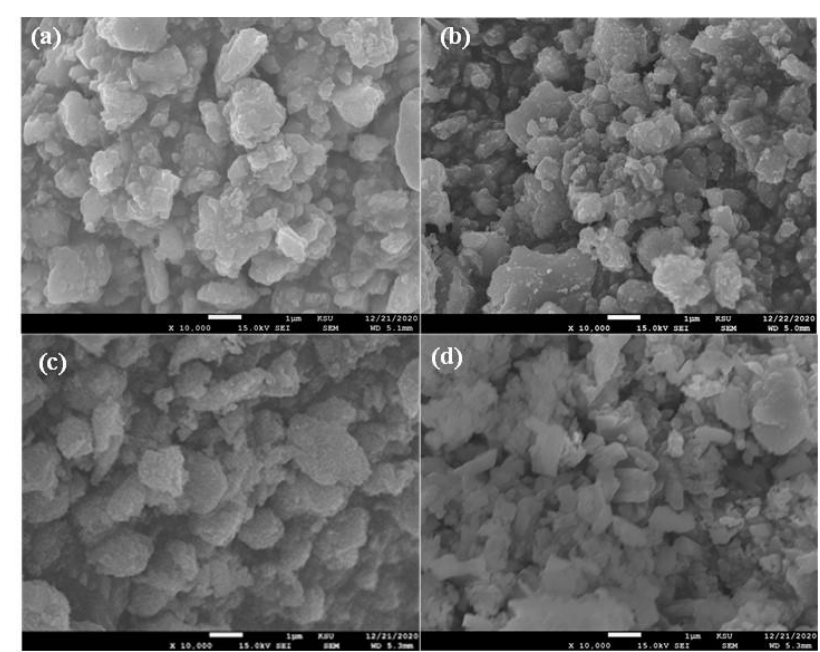
Figure 2. SEM images of ( a ), ( b ) Sr 2 CoO 3 F, ( c ) Sr 2 CoO 3 Cl, and ( d ) Sr 2 CoO 3 Br catalysts.